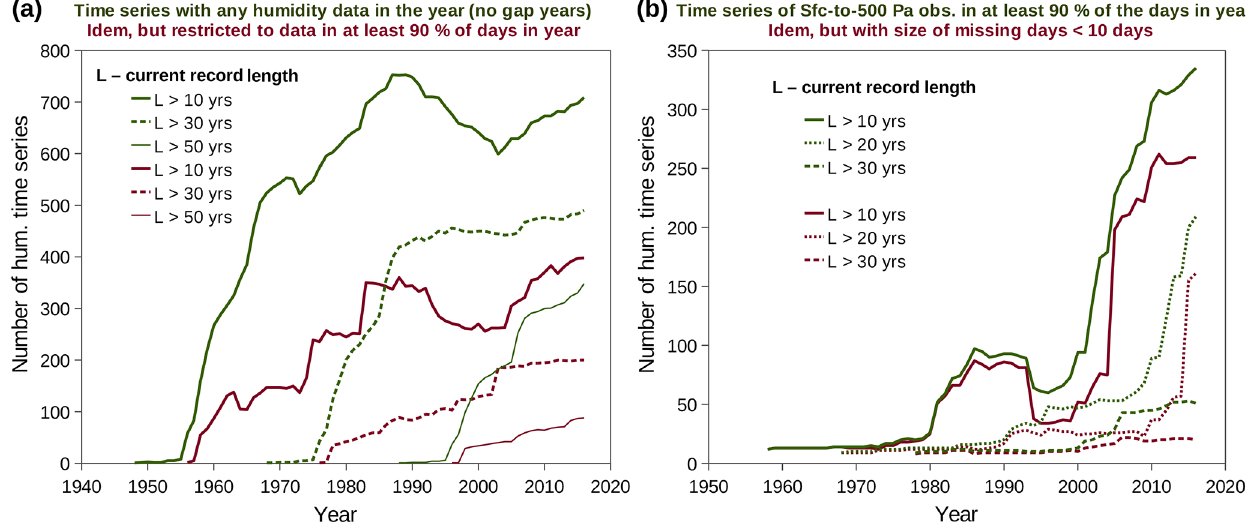
Figure 11. Number of humidity time series with a record length exceeding a given number of years until the year in abscissa (see insets), under different completeness criteria (indicated on top of the